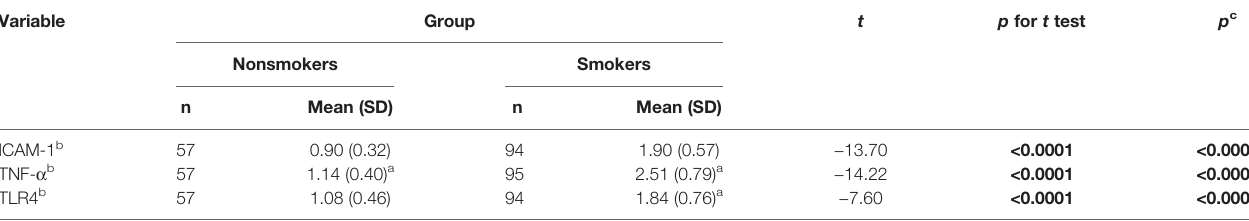
TABLE 2 | Comparisons of mononuclear cell markers in smokers (n = 97) and nonsmoker controls (n = 62). Variable Group